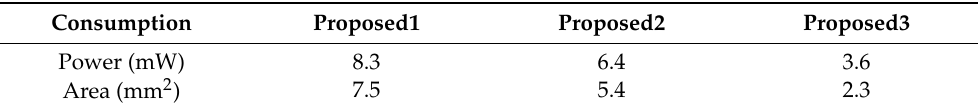
Table 3. Post-synthesis consumption of multichannel architecture with flip-flops-based memory with hamming smoothing (proposed1), a latches-based memory of proposed1 (proposed2) and our finals proposal including a RAM latches-based with the equivalent IIR